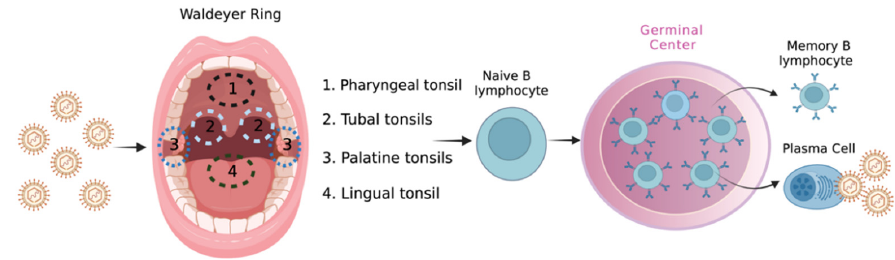
Figure 1. Model of primary infection by Epstein–Barr virus in the oropharynx. In epithelial cells, it is suggested that EBV entry is achieved due to the attachment of the viral gB and the receptor ‐ binding complex gH/gL to the host Ephrin A2 (EphA2) re ‐ ceptor, which allows EBV entry by membrane fusion [47,48]. The viral genome is trans ‐ ported to the host nucleus where EBV finely regulates the expression of lytic genes. EBV lytic activation requires the coordinated expression of two viral immediate ‐ early (IE) pro ‐ teins: Zta, a leucine zipper DNA ‐ binding protein (also called BZLF1, Zebra or EB1), and Rta protein (also called R) [49,50]. Zebra protein is a transcription factor that interacts with the Z response elements (ZREs) binding sites to activate the transcription of early genes required for viral DNA replication such as BALF5, BBLF4, BSLF1 and BMRF1 [51,52]. The replication complex amplifies the viral genome in a rolling ‐ circle mechanism allowing the genesis of concatemers [53]. After replication, latent genes such as BGLF3, BDLF4, BVLF1, and BDLF3 are expressed to form structural proteins of the nucleocapsid, tegument and surface glycoproteins. These components form the viral particle which, when released to the outer host membrane, cause cell lysis [54]. 4. Breast Cancer and EBV Epidemiology EBV was the first human virus described as oncogenic and classified as carcinogen class I by the International Agency for Research on Cancer (IARC) [55]. Two epithelial tumors have been clearly associated with EBV infection: undifferentiated NPC which har ‐ bors EBV in almost 100% of cases and gastric cancer (GC) in almost 10% of cases. [56]. Additionally, EBV is strongly linked to malignancies such as Burkitt’s lymphoma (BL), Hodgkin’s lymphoma (HL), and T ‐ cell lymphoma [57–61]. Interestingly, some lymphocyte ‐ rich types of BC are morphologically similar to NPC [62,63]. There are well ‐ documented publications that have evaluated the presence of EBV infection in BC [18,64,65]. However, the etiological role of EBV in BC is controversial, which may be attributable to different molecular techniques used, the type of clinical spec ‐ imen, low expression of EBV proteins, and geographic or socioeconomic heterogeneity [66]. In 1995, Labrecque et al. first reported EBV presence in 19/91 (21%) BCs by polymer ‐ ase chain reaction (PCR). Additionally, EBER ‐ 1 was detected in 6/19 (31.5%) BCs by in situ hybridization (ISH). Moreover, a non ‐ statistically significant association with histopatho ‐ logical features was found [18]. Recent studies have also reported that between 30 and 50% of BCs are positive for EBV. Indeed, in 2001 Fina et al. collected 509 IDCs samples and found that 162/509 (31.8%) were EBV ‐ 1 positive, with no positive correlation among geographical areas or clinicopathological features [67,68]. In 2001, Chu et al. analyzed 48 BCs by multiple techniques and detected EBER ‐ 1 in 5/48 (10%) by ISH, EBNA ‐ 1 in 12/48 (25%) cases by IHC but failed to detect LMP ‐ 1 and ZEBRA proteins. Furthermore, EBNA ‐ 4 and LMP ‐ 1 gene fragments were detected by PCR in 7/48 (15%) cases. However, results were not conclusive because only a small subset of tumoral cells was EBER ‐ 1 positive and detection of prominent lymphocytic infiltration was only found in 5/7 (71%) PCR ‐ positive cases [69]. In 2005, Kalkan et al. found EBV in 13/57 (23%) of BC tissues by PCR. However, EBV was found in 19/55 (35%) of control samples, suggesting no direct association